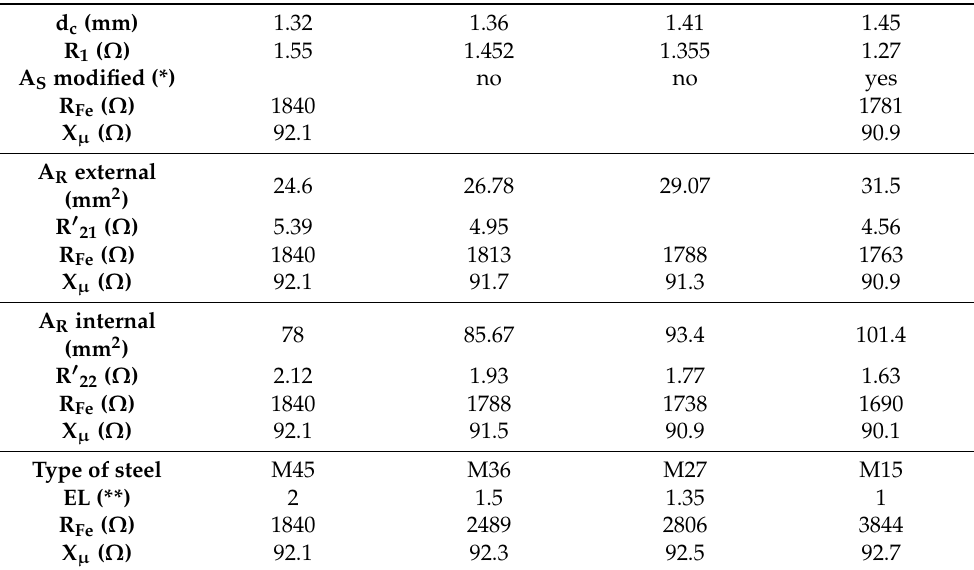
Table 4. Construction variations studied in the 7.5 kW